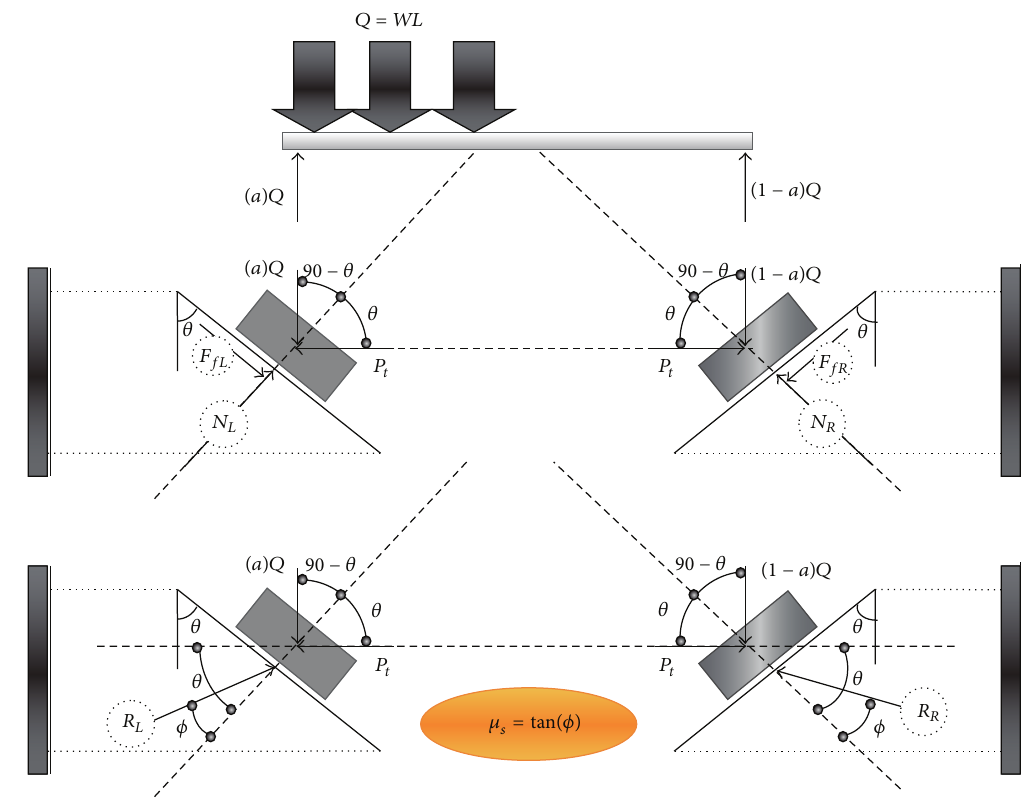
Figure 9: Free body diagram of beam with nonsymmetric gravity load after increase in temperature (friction support).